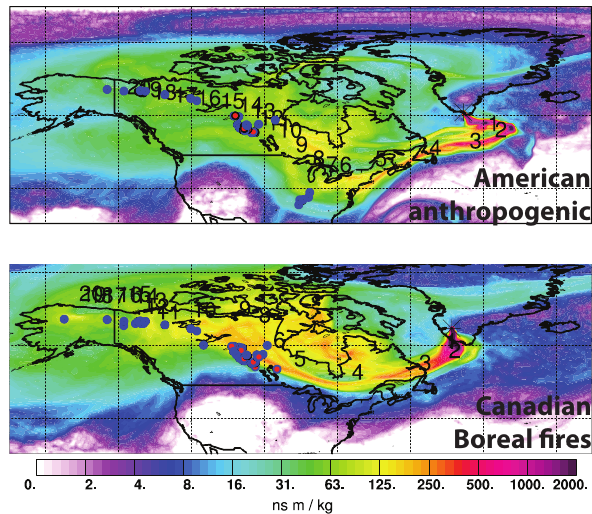
Fig. 3. FLEXPART North American column-integrated poten- tial emissions sensitivities (PES). Examples for American anthro- pogenic (AN) and Canadian boreal fire (BF) origins are presented in the upper and lower panel, respectively. The red dots indicate for- est fires while the blue dots express other fires (mostly agricultural), both detected by MODIS. Numbers on the two panels indicate the daily retroplume centroid positions, as FLEXPART calculates back in time. Values are plotted in a logarithmic